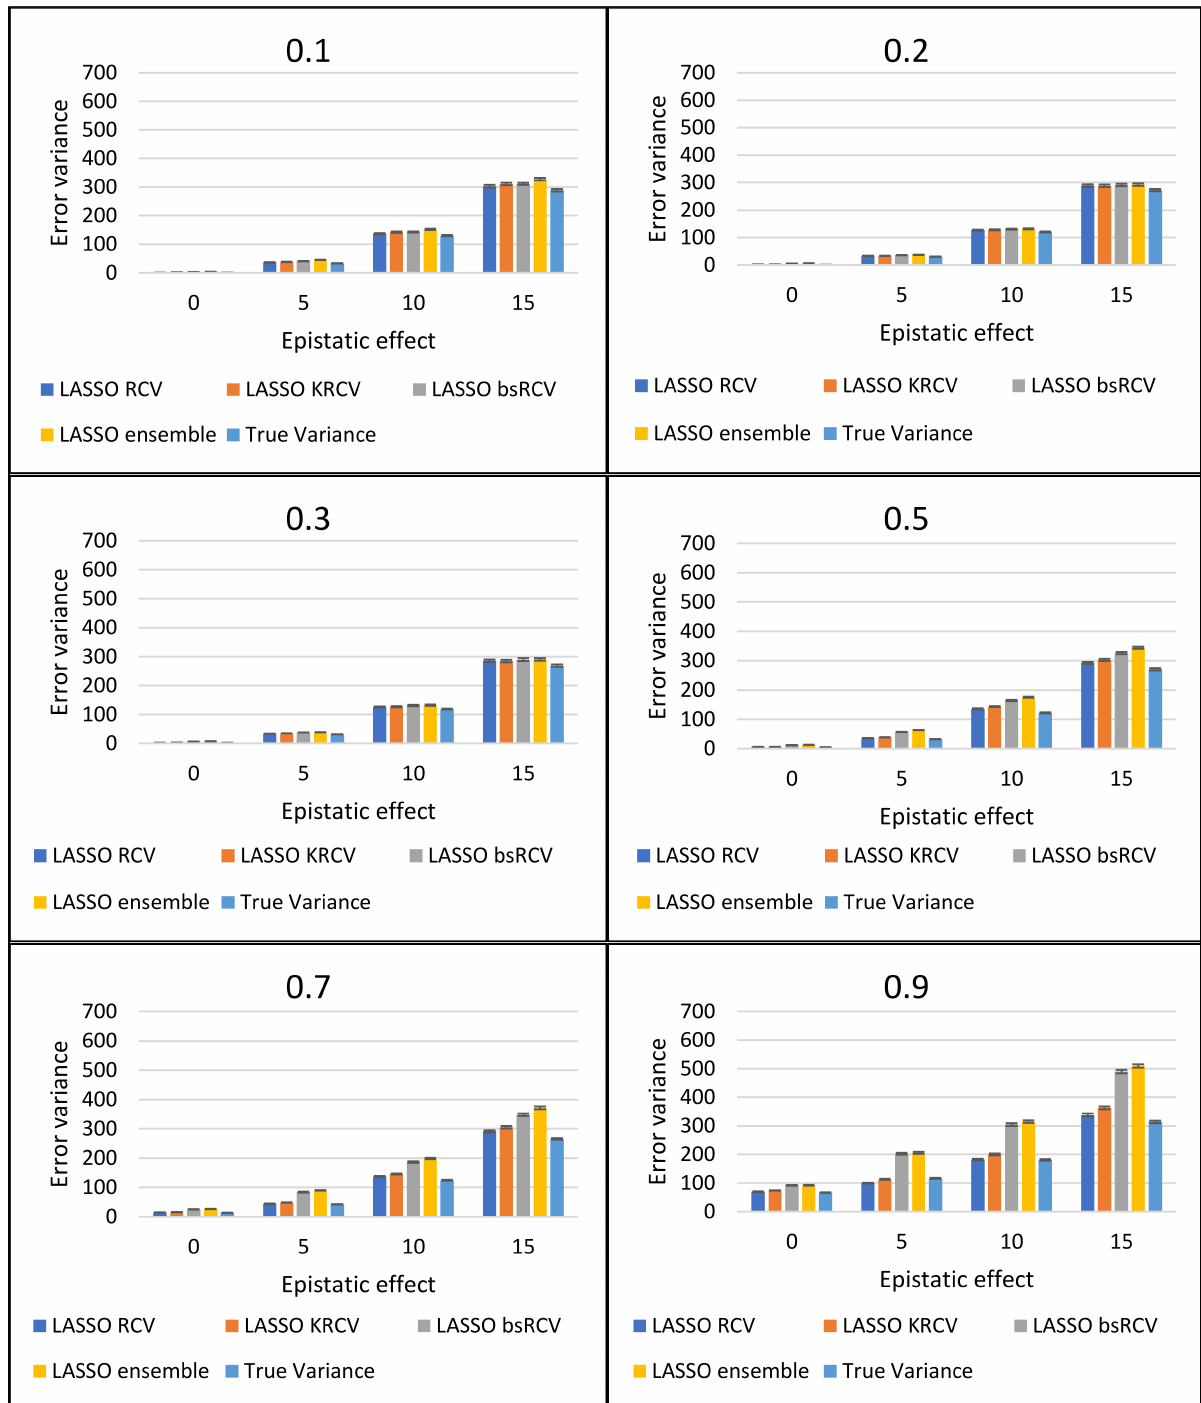
Figure 6. Comparison of RCV, k-RCV, bs-RCV and Ensemble method for LASSO. RCV: Refitted Cross Validation, k-RCV: kfold Refitted Cross Validation, bs-RCV: Bootstrap RCV, LASSO: Least Absolute Shrinkage and Selection